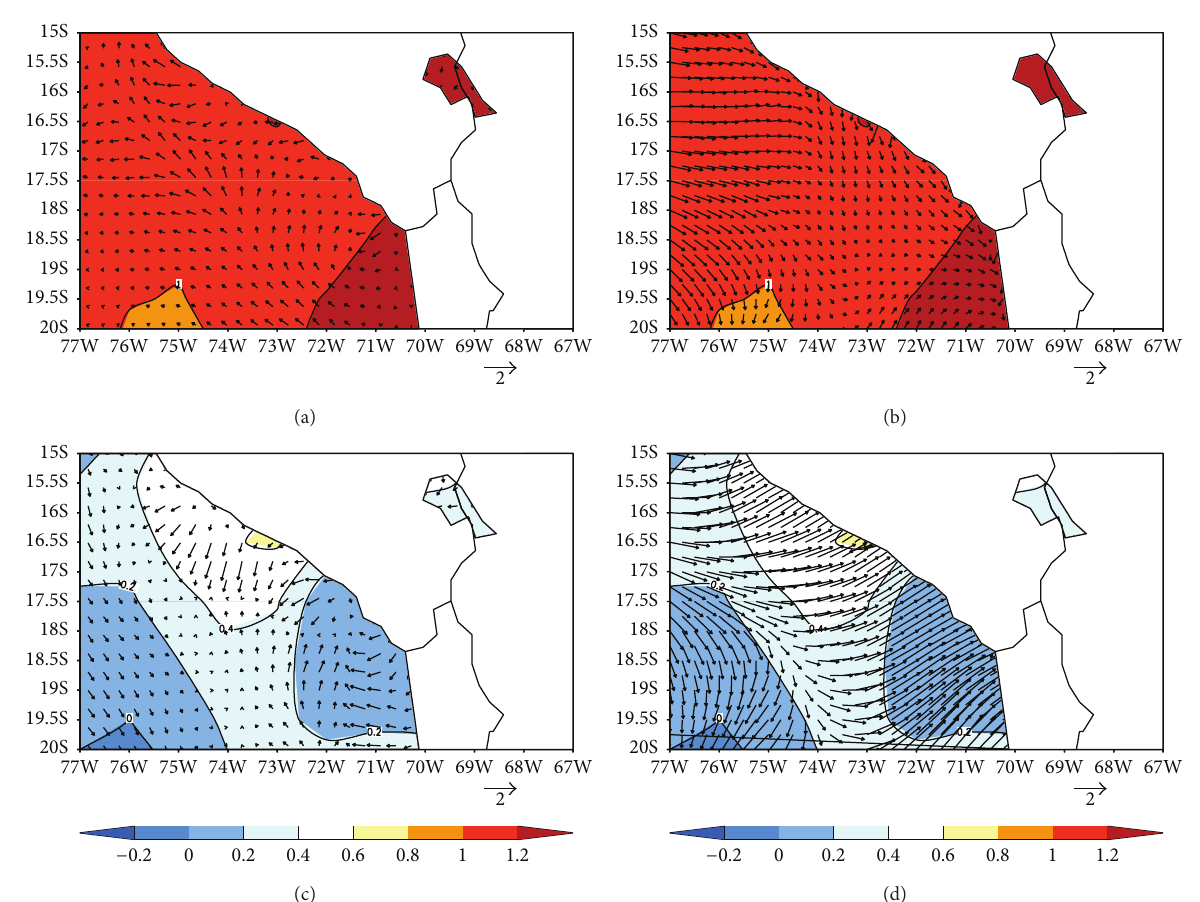
Figure 7: (a) El Ni˜no composite (El Ni˜no—Neutral) for (a) CFS reanalysis surface wind vector (units: standard deviation), NOAA OI SST shaded, (units: standard deviation). (b) Like (a) except for using winds from NOAA’s blended sea-wind data. (c) like (a) except for La Ni˜na. (d) Like (b) except for La